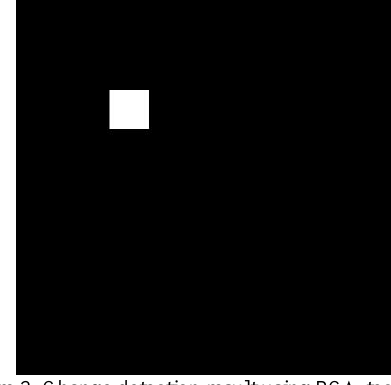
Figure 2. Change detection result using PCA technique